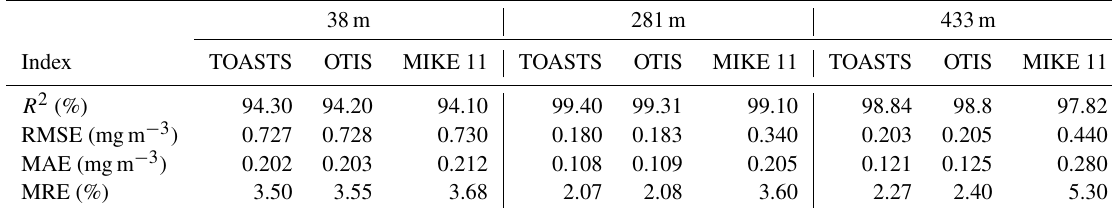
Table 11. Error indices of simulation of the Uvas Creek experiment (test case 3).